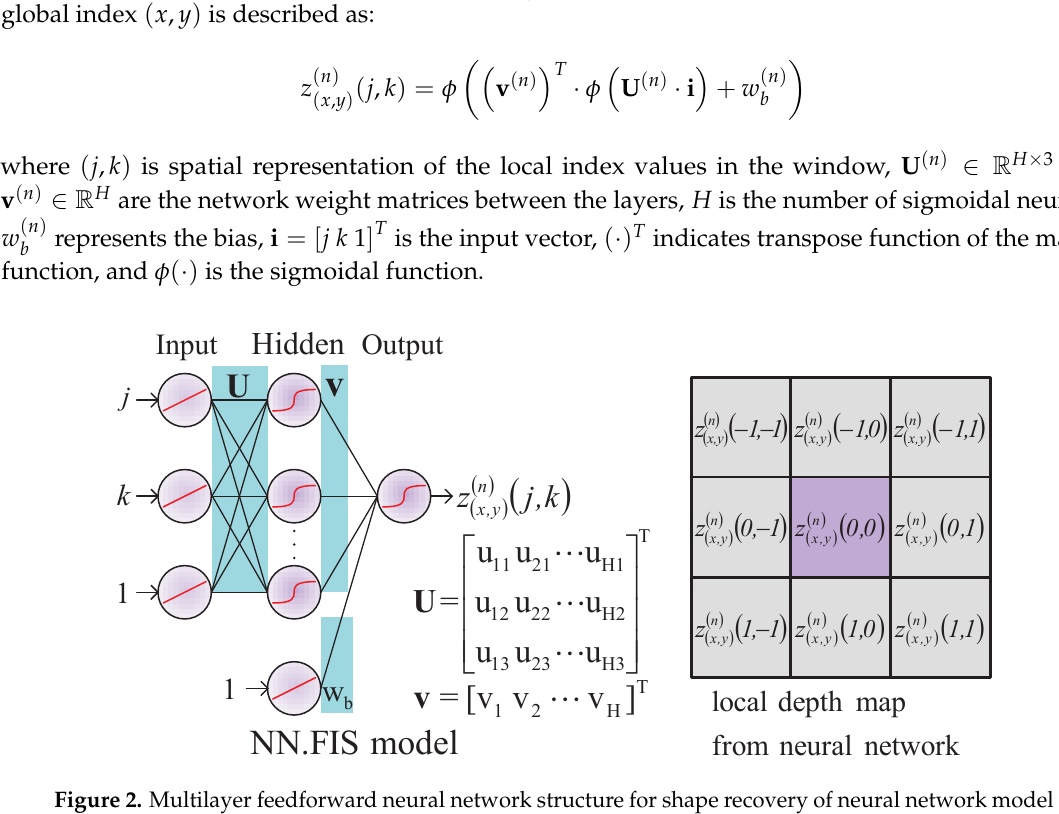
Figure 2. Multilayer feedforward neural network structure for shape recovery of neural network model over FIS and local depth map from the neural network model. Left : NN.FIS model; Right : local depth map from NN.FIS model. The local depth map consists of 9 neighboring pixels centered around ( x , y ) , when small window size is 3 × 3. In addition, each local depth is produced by network with changing the local index j and k